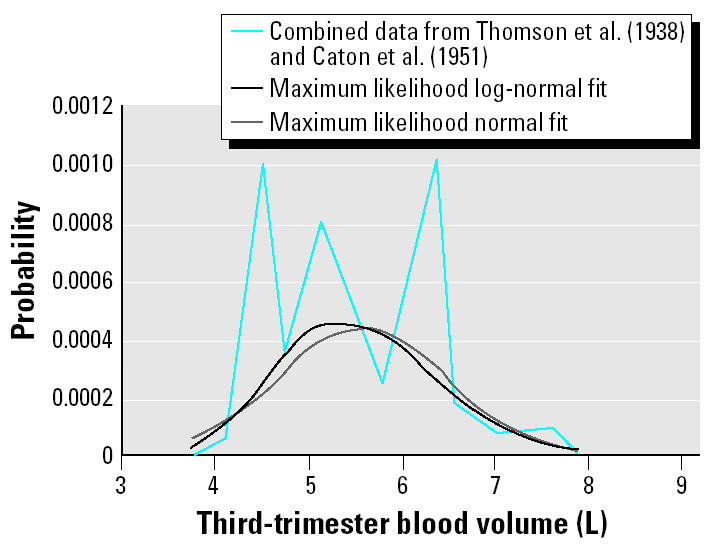
Combined third-trimester blood volume data from Thomson et al. (1938) and Caton et al. (1951) compared with maximum likelihood normal and log-normal distributions.